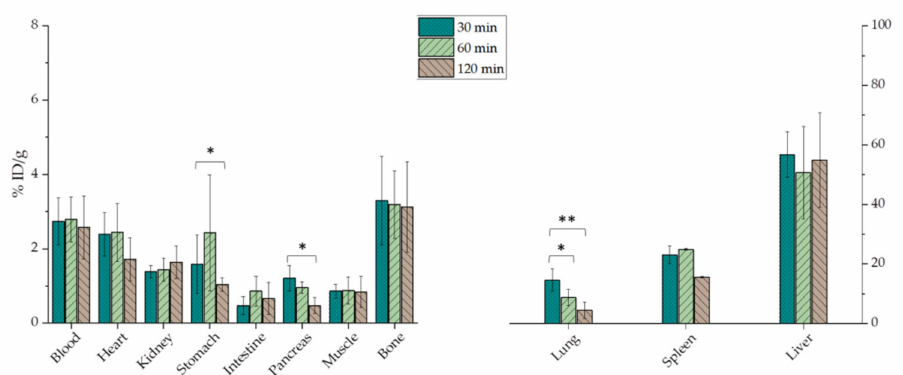
Figure 9. Biodistribution of [ 68 Ga]Ga-MagP-NODAGA MIONs in normal mice ( n = 3–5 mice per time point). Asterisks indicate the statistical significance of the difference between the results (* p < 0.05, ** p < 0.01, *** p < 0.001). Absence of asterisks denotes a nonsignificant statistical